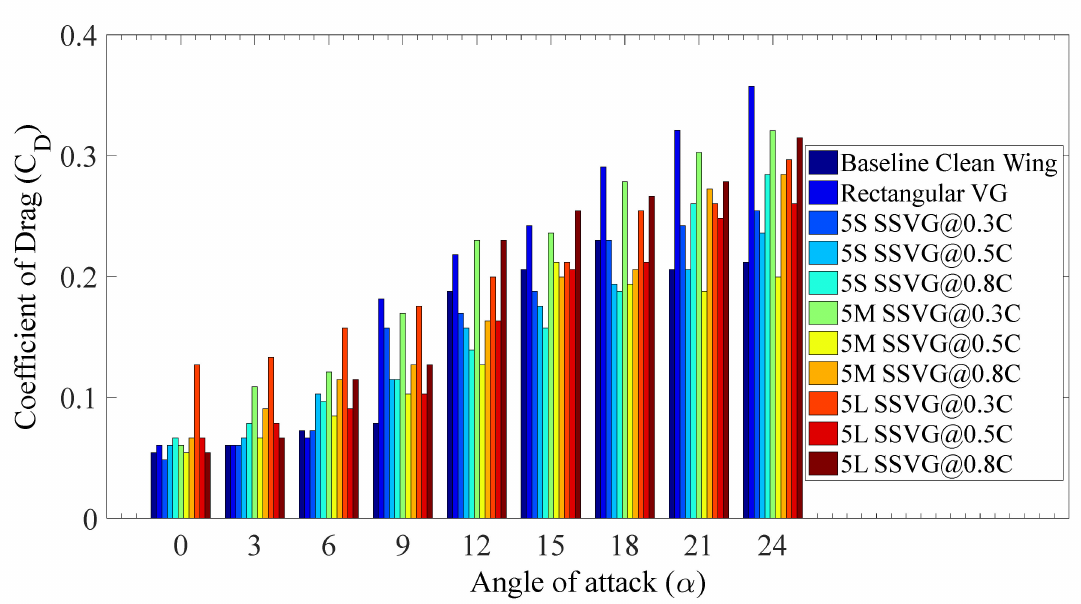
Figure 20. Comparison of the coefficient of drag ( C D ) over baseline and modified wings with 5S, 5M, and 5L SSVG at various chordwise